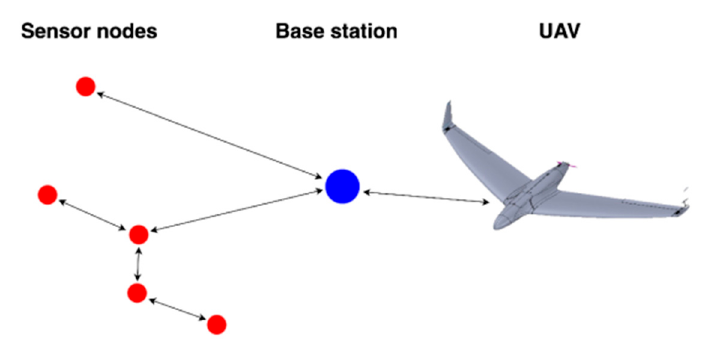
Figure 6. General configuration of UAV–WSN system implementation.